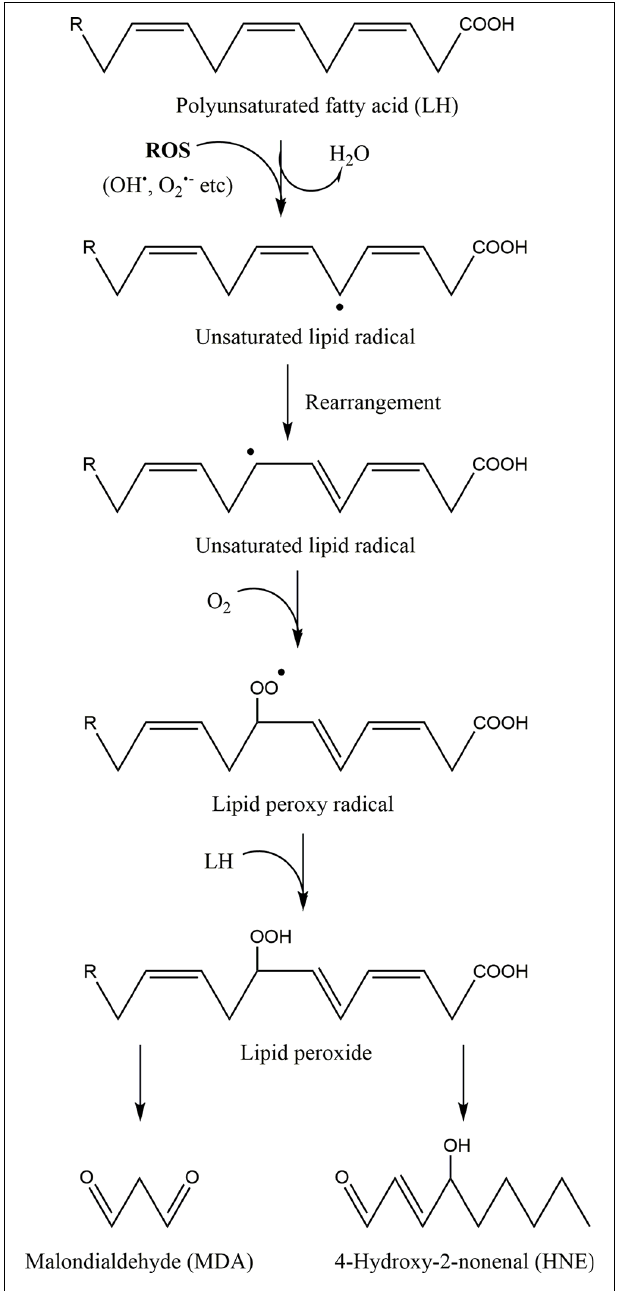
FIGURE 5 | The process of lipid peroxidation of polyunsaturated fatty acids. First a free radical or reactive oxygen species (ROS) remove an electron from a methylene group between two double bonds of a polyunsaturated fatty acid (LH) leading to the formation of a new free radical (unsaturated lipid radical). The lipid radical formed is very unstable, resulting in its rapid rearrangement and the formation of a similar unsaturated lipid radical. This radical reacts with molecular oxygen towards a lipid peroxy radical. This peroxy radical can extract a hydrogen atom from an adjacent polyunsaturated fatty acid, thereby creating a new free radical and a lipid peroxide. These radical chain reactions further propagate and their main degradation end-products are malondialdehyde (MDA) and 4-hydroxy-2-nonenal (HNE), which are relatively stable. Hence, MDA and HNE can be used as a means of quantifying the levels of oxidative stress and lipid peroxidation within